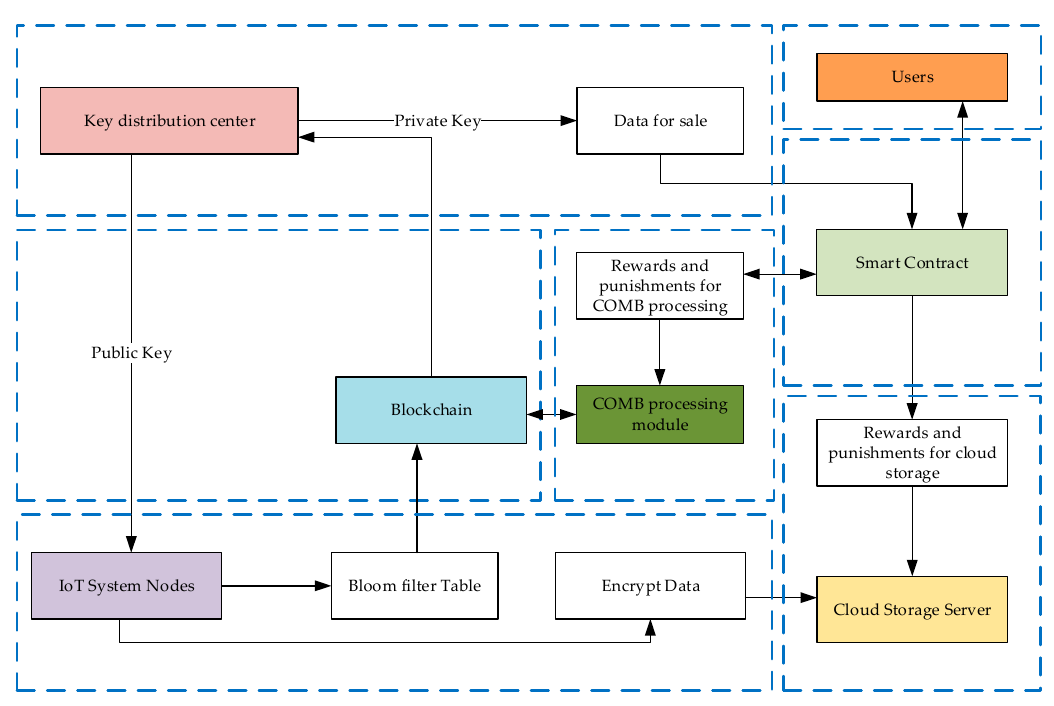
Figure 3. Blockchain-based IoT data model .